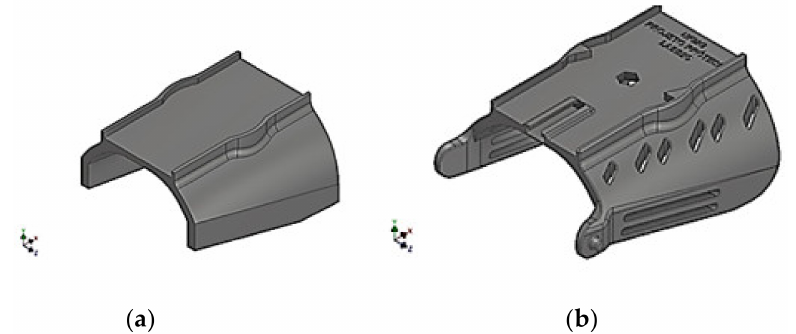
Figure 8. CAD development of the wrist support region: ( a ) simple geometry of wrist support, ( b ) developed wrist